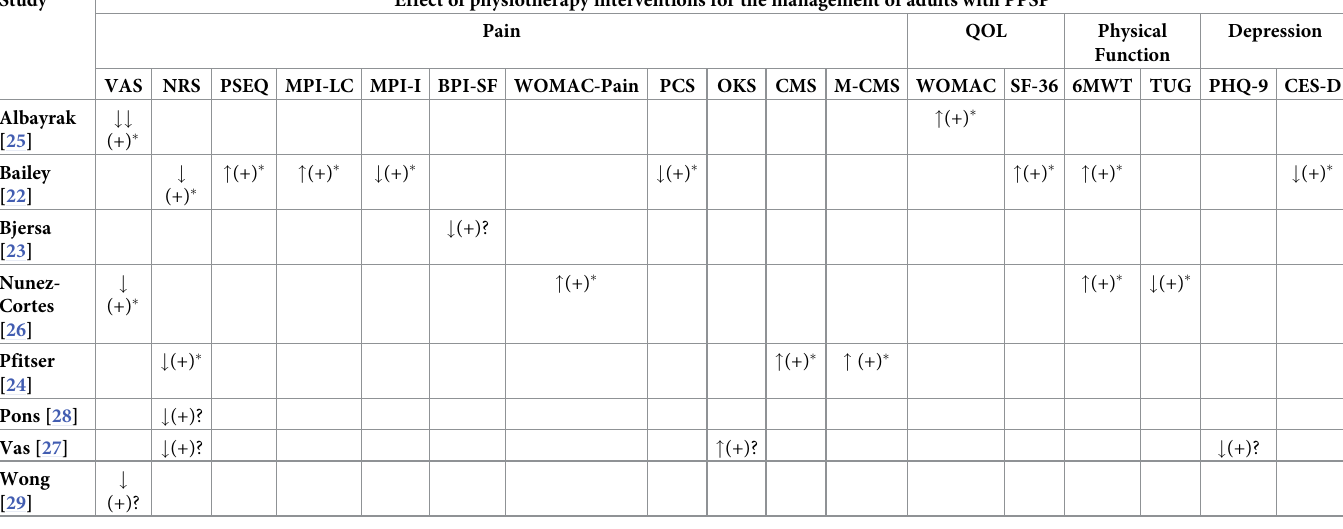
Table 4. Summary of results. Study Effect of physiotherapy interventions for the management of adults with